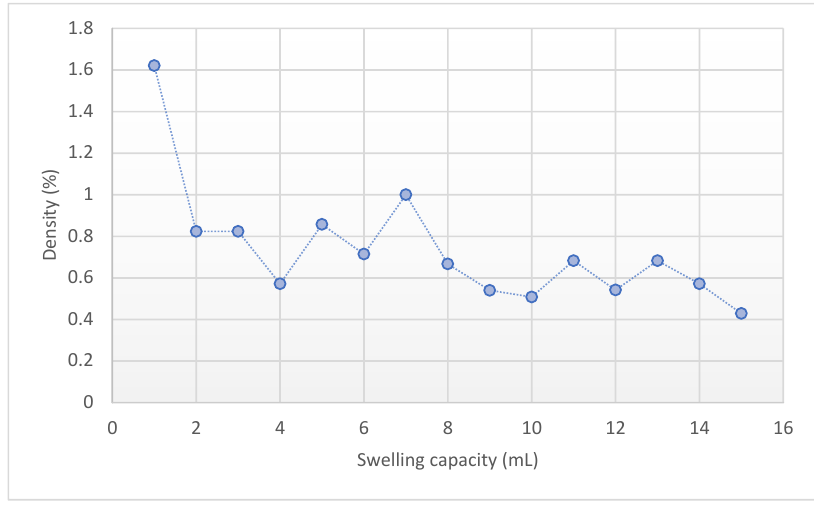
Figure 11. Decrease of density by raise of swelling capacity by 110% for the pure (silica-free) particles.